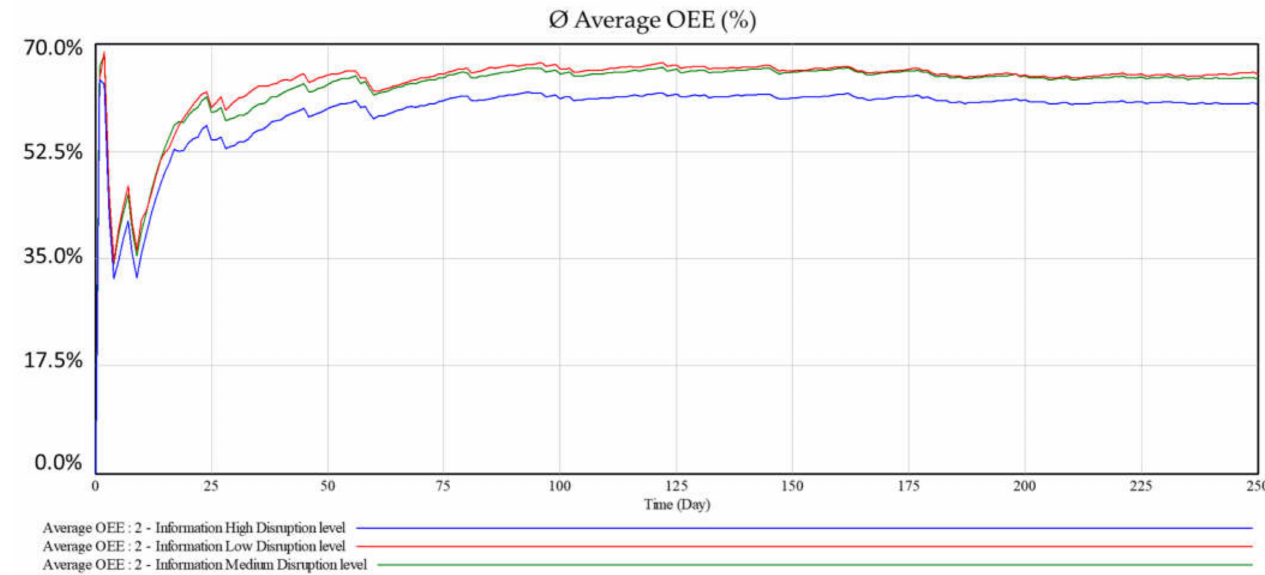
Figure 8. Average OEE (%) results for information flow disruptions: low, medium, and high